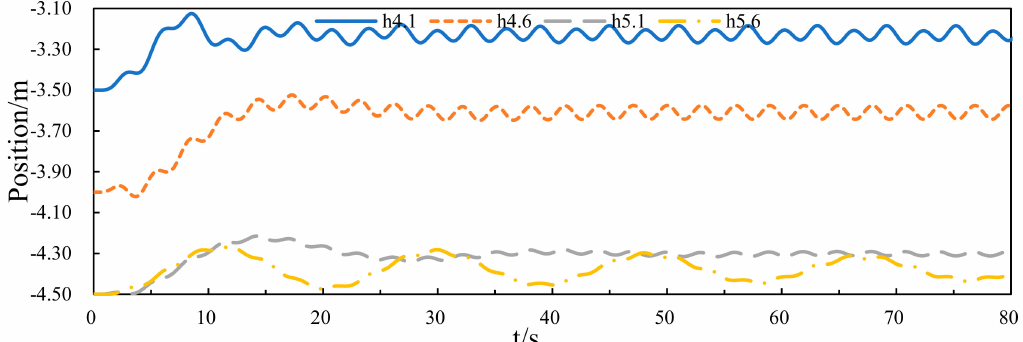
Figure 20. Oscillation curve of the central